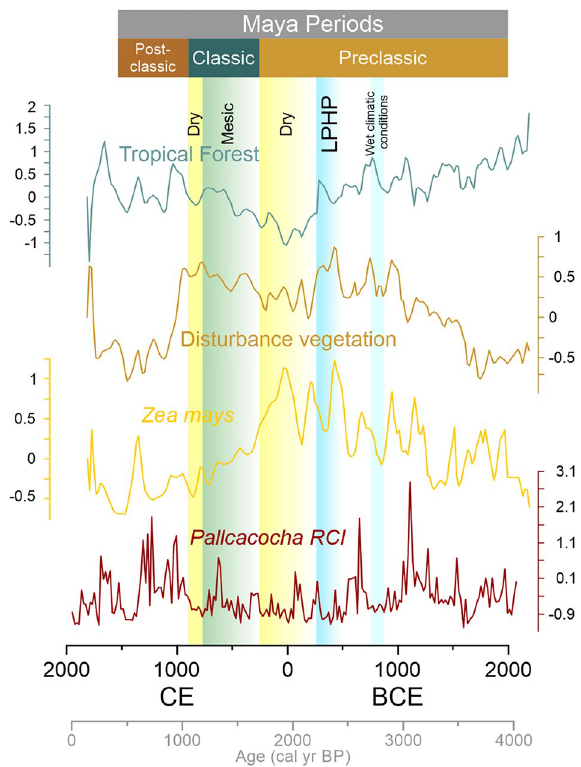
Figure 3. Average Z-scores values of fossil pollen groups: Tropical Forest, Disturbance vegetation, Zea mays , and Pallcacocha RCI (red color intensity) as ENSO Variability 54 . Periods of previously reported general climate variability are highlighted in